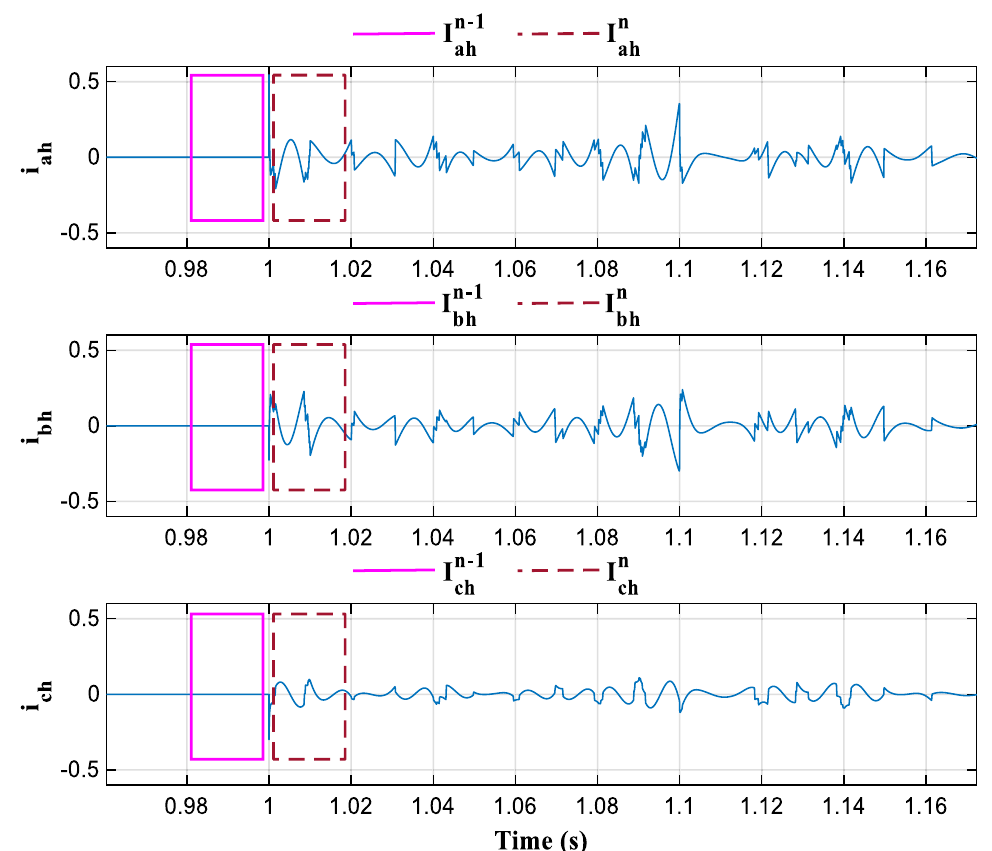
Fig. 4 The high-frequency components of three-phase currents in case of an inter-turn fault ( µ = 0.05